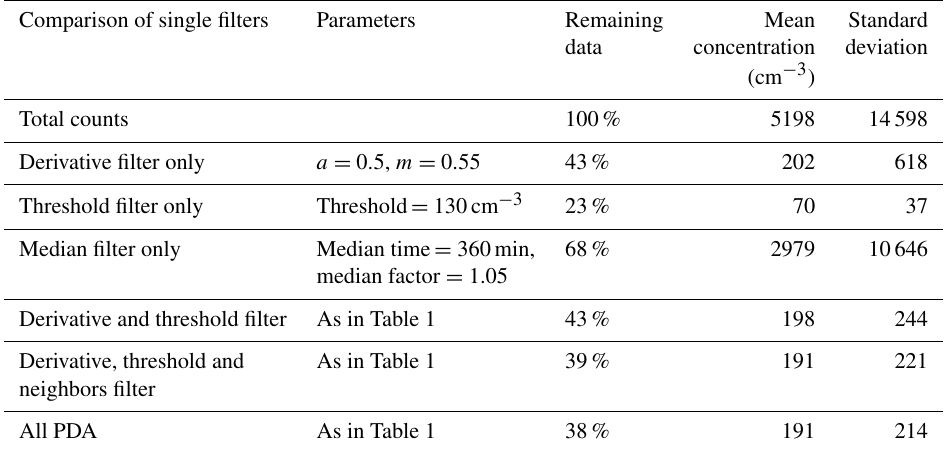
Table B1. Percentage of data declared as unaffected when different filtering steps are applied and the mean concentrations and standard deviations of the corresponding particle number concentrations.